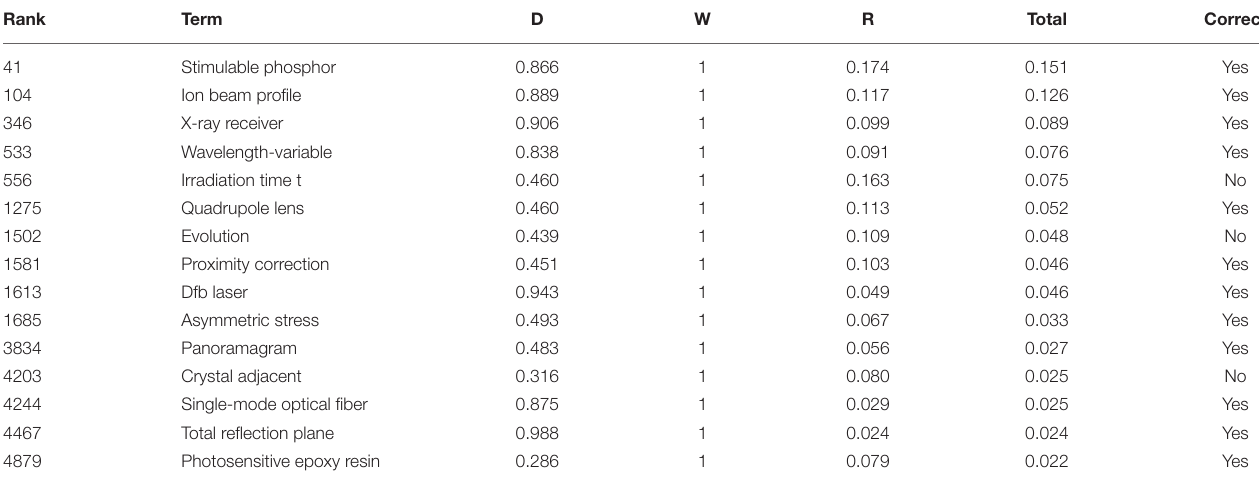
TABLE 3 | System Output with aggregate scores, component scores and correctness